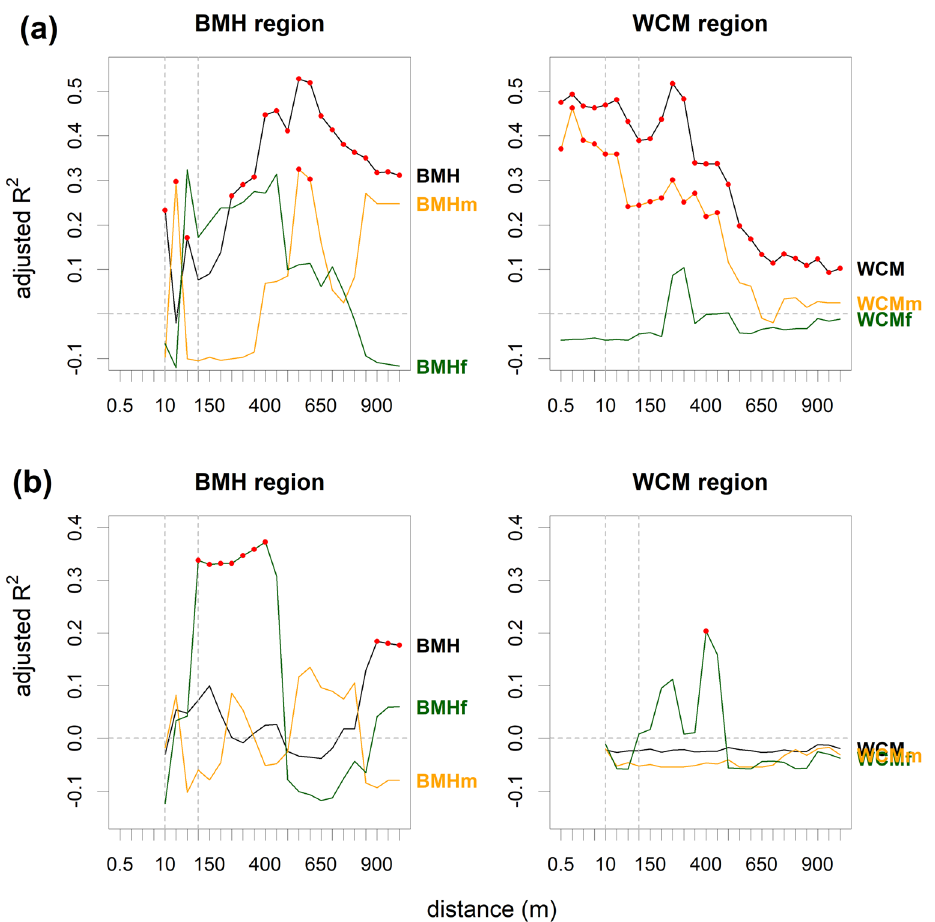
Figure 4. The strength of linear regression between ( a ) pollen richness and plant richness at different distances from sampling sites and ( b ) local contributions of sites to pollen and plant BD Total at different distances from sampling sites. The black line shows the correlation for all sites, the orange line for sites in open habitats, and the green line for forest sites. Red dots indicate significant